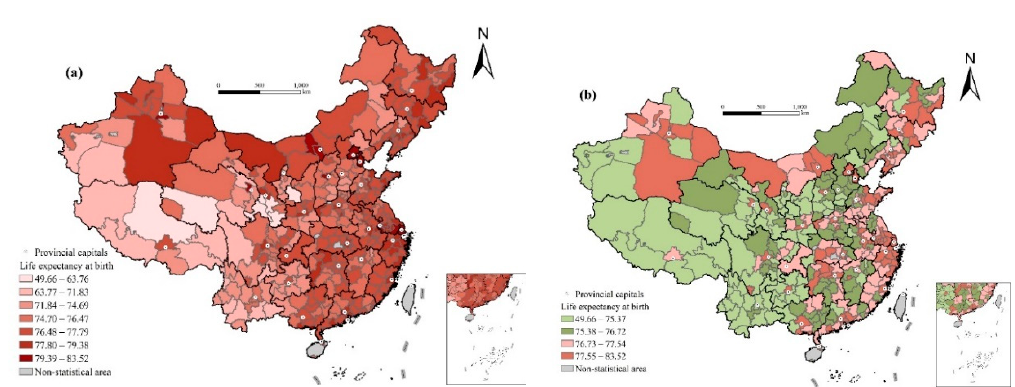
Figure 2. Spatial distribution of life expectancy at birth in prefecture-level cities in 2010: ( a ) the whole spatial pattern; ( b ) quartiles.